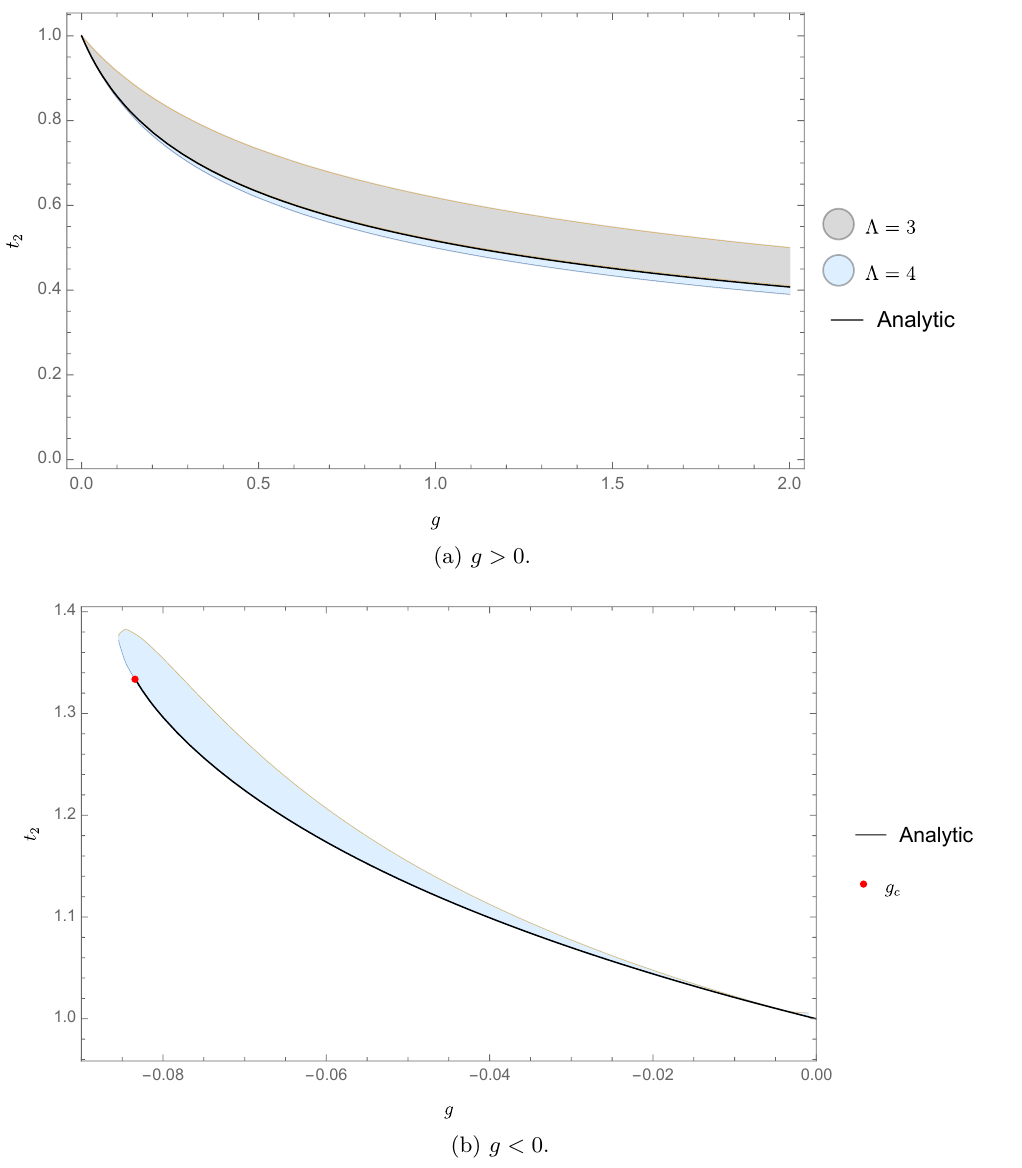
Figure 5 . Comparison with the exact analytic solution of model (5.1) with h = 0 , i.e. two decoupled quartic one-matrix model. The lower plot is for Λ = 8